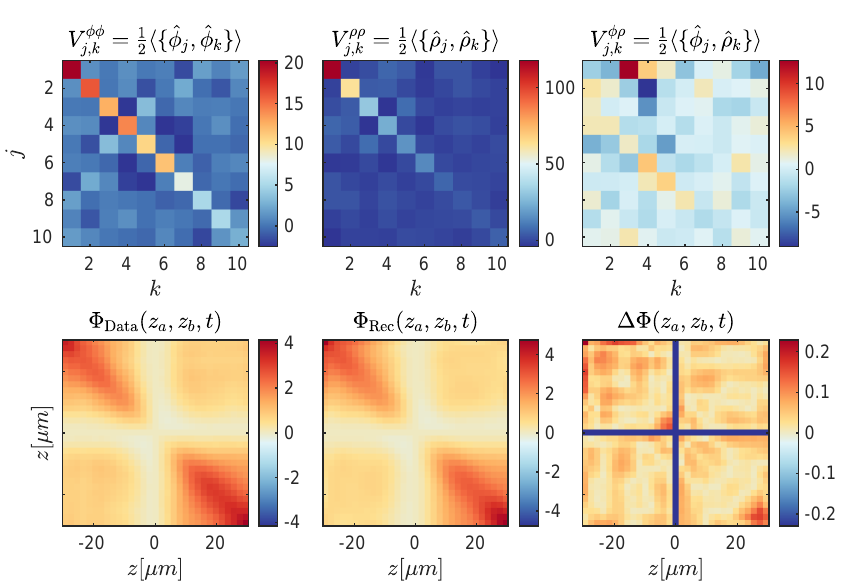
Figure 8: Top: Reconstructed initial state correlations in the eigen-mode basis. Bottom: The tomographic recovery is performed by matching the measured phase second moments at times t = 0,1,...,12ms. Here, we show the comparison for the initial time. The cost function ∆Φ is the relative deviation of the reconstructed second moments Φ from the data Φ , weighted by the estimate of the root-variance at Rec Data the given